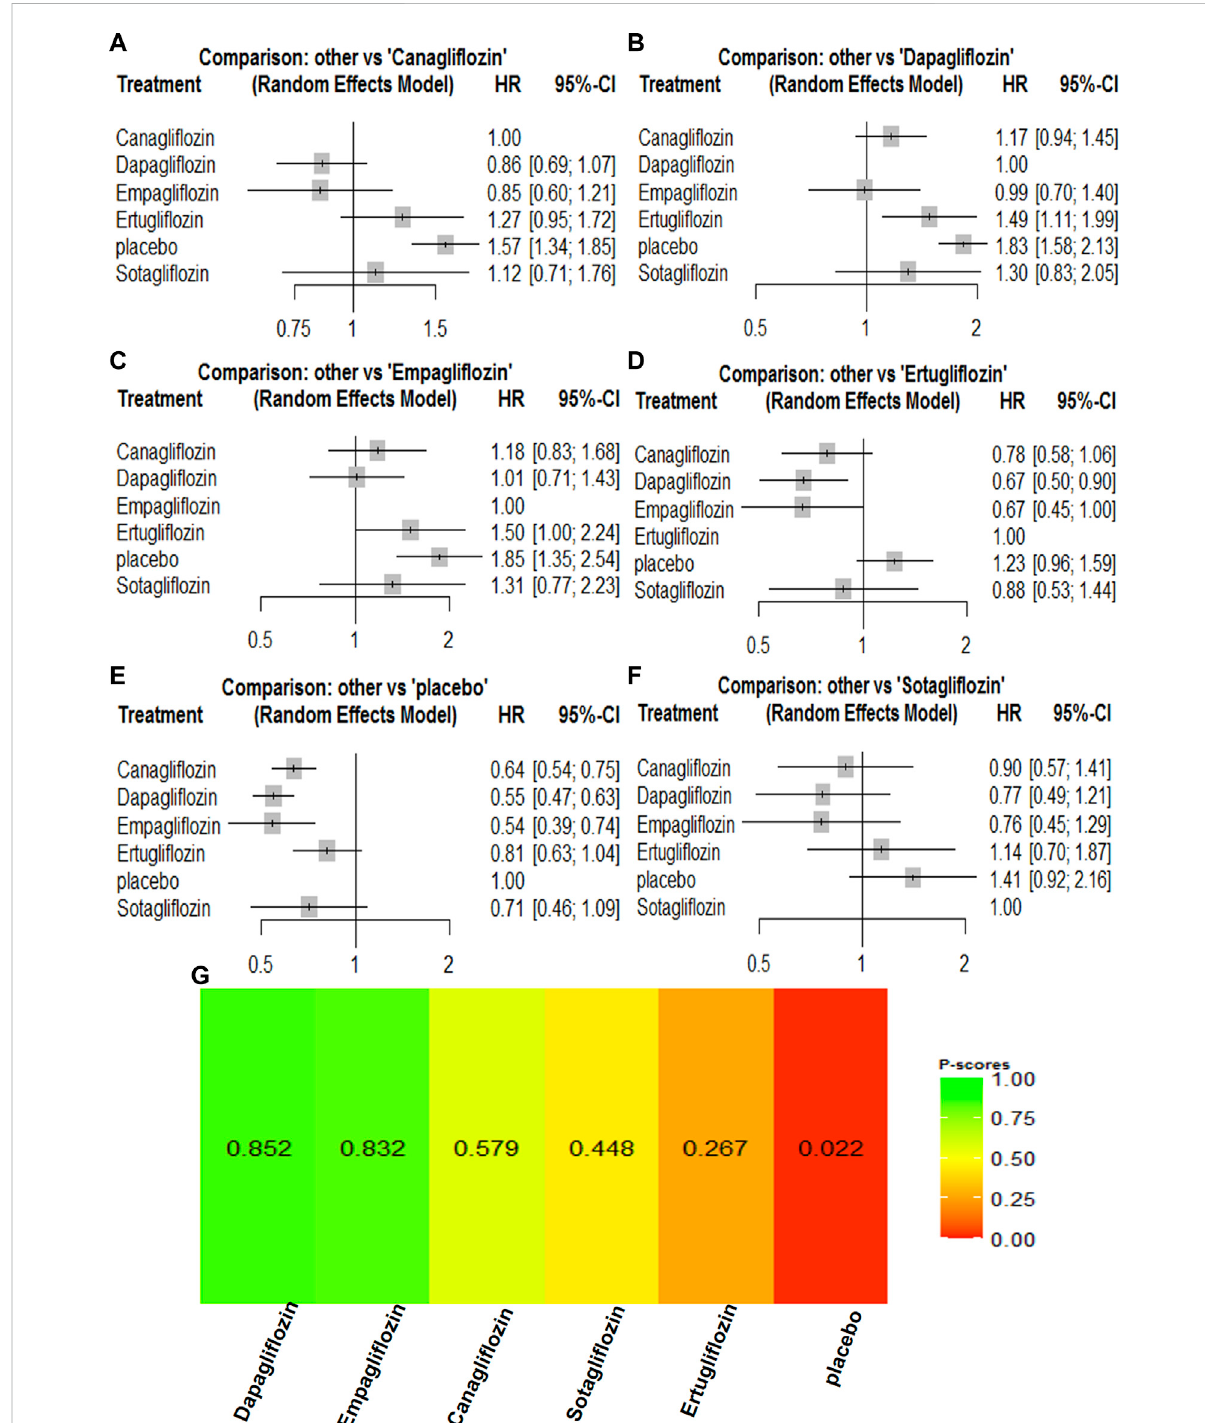
FIGURE 5 Forest Plots and Ranking Plots of Network Meta-analysis of all trials for Composite Renal Outcome. (A) Forest Plots of other drugs compare to canagli fl ozin. (B) Forest Plots of other drugs compare to dapagli fl ozin. (C) Forest Plots of other drugs compare to empagli fl ozin. (D) Forest Plots of other drugs compare to ertugli fl ozin. (E) Forest Plots of other drugs compare to placebo. (F) Forest Plots of other drugs compare to sotagli fl ozin. All effectestimatesareexpressedashazardratios(HRs)fortreatmentvsthecomparatorand95%credibleintervals(95%-CI).Forexample,theHRs incompositerenaloutcomefordapagli fl ozincomparedtocanagli fl ozinis0.86(95%-CI0.69to1.07).Thex-axisscaleindicatestherangeoftheHRs. (G) Ranking Plots of Network Meta-analysis. Plots below the forest plots show for the rank of each drug class and ranking descending from left to right, The p-score represents the power of the